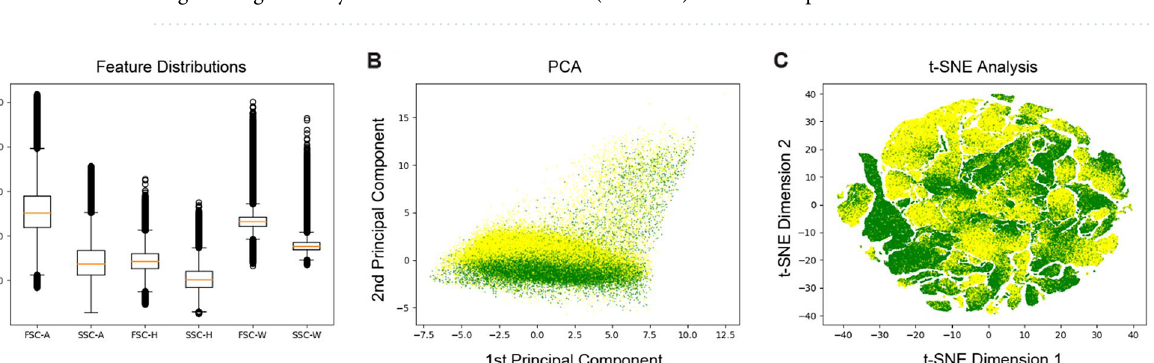
Figure 1. Generation and characterization of heterozygous FCD-deficient KU-812 cell model (FCD-HT). ( A ) Schematic illustration of the CRISPR/SpCas9 homologous recombination process to remove the FCD motif within human globin locus. The polyclonal stable cell line was established using 2 weeks of puromycin selection (2 µg/mL). Subsequently, the puromycin resistance gene transcript, which was flanked by flippase recognition target (FRT) sites, was removed using flippase. Finally, monoclonal stable cells were established using FACS single cell sorting. ( B ) Genotyping of FCD-HT monoclonal stable cell. Genomic DNAs were harvested from FCD-WT and FCD-HT cells and the transcript containing the FCD motif or FRT site was PCR amplified and subsequently subjected to gel electrophoresis. The stable cell line yielded two bands corresponding to both the wild type (806 bp) and FCD-knockout (341 bp) alleles, confirming its heterozygous status. ( C ) Quantitative reverse transcription-PCR (qRT-PCR) assay showed that compared to FCD-WT cells, the mRNA level of ϒ -globin significantly increased in FCD-HT cells (2.87-fold). *** denotes p-value < 0.001.